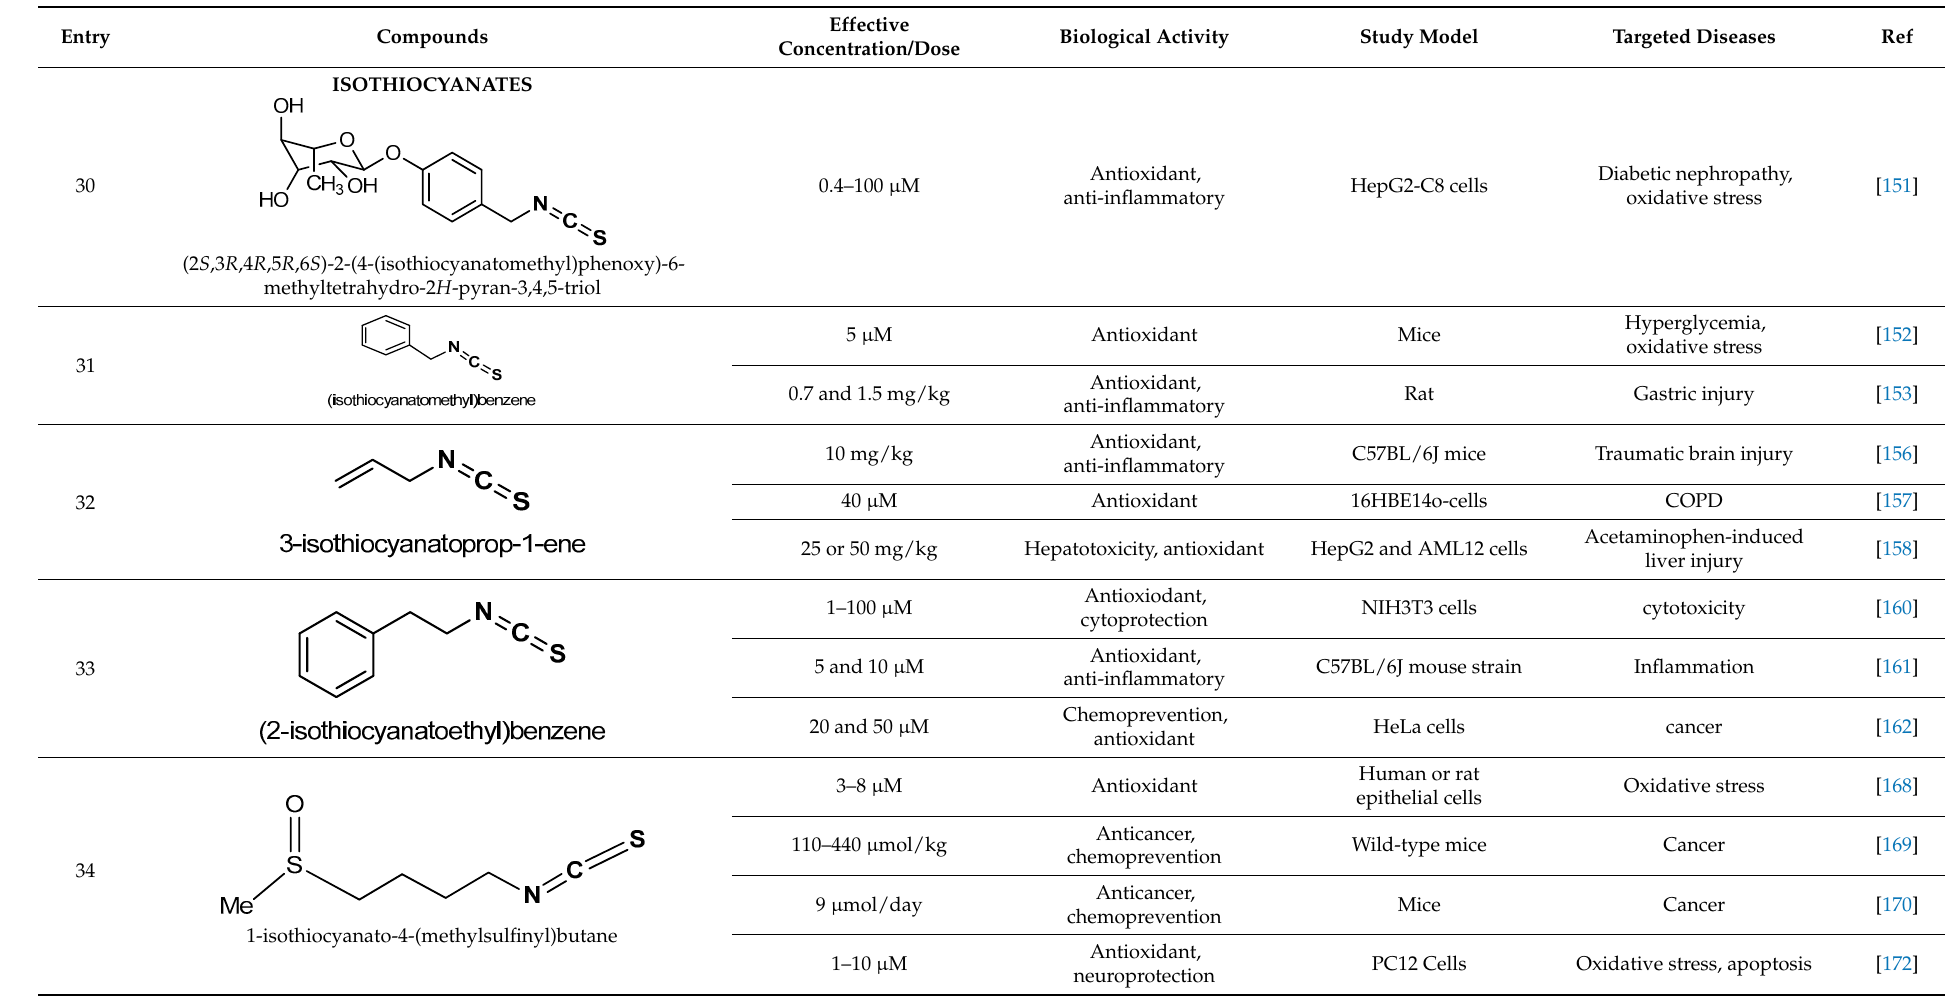
Table 2. Natural organosulfur compounds and their Nrf2 activation.